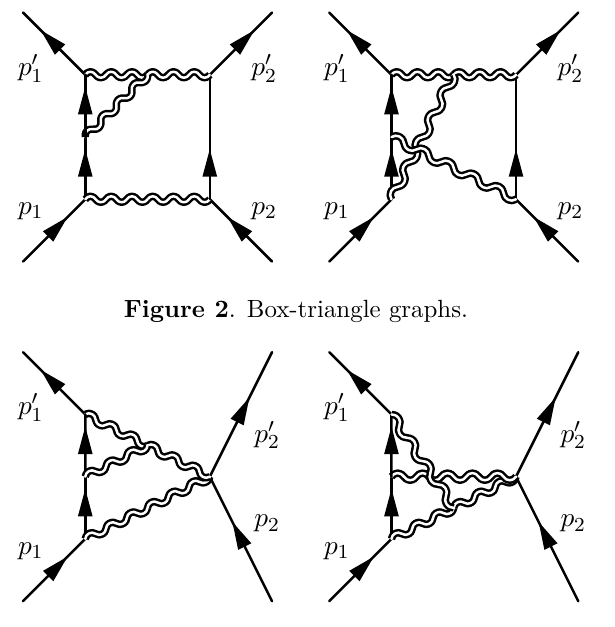
Figure 3 . Double-triangle